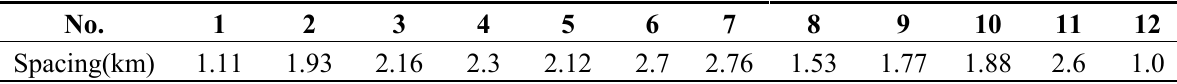
Table 1. TSS spacing distances.